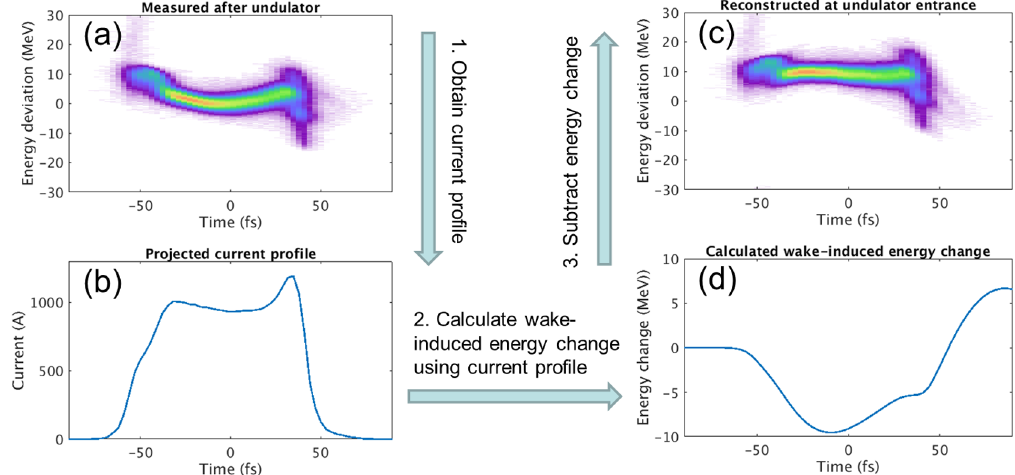
FIG. 7. The procedure to retrieve the initial phase space at the undulator entrance. The final measured longitudinal phase space is in (a), and by projecting to time, we obtain the current profile (b). Using the resistive wall wakefield model, the induced energy loss is calculated in (d). Finally the initial phase space (c) is obtained by subtracting the energy loss in (d) from (a). Bunch head is to the